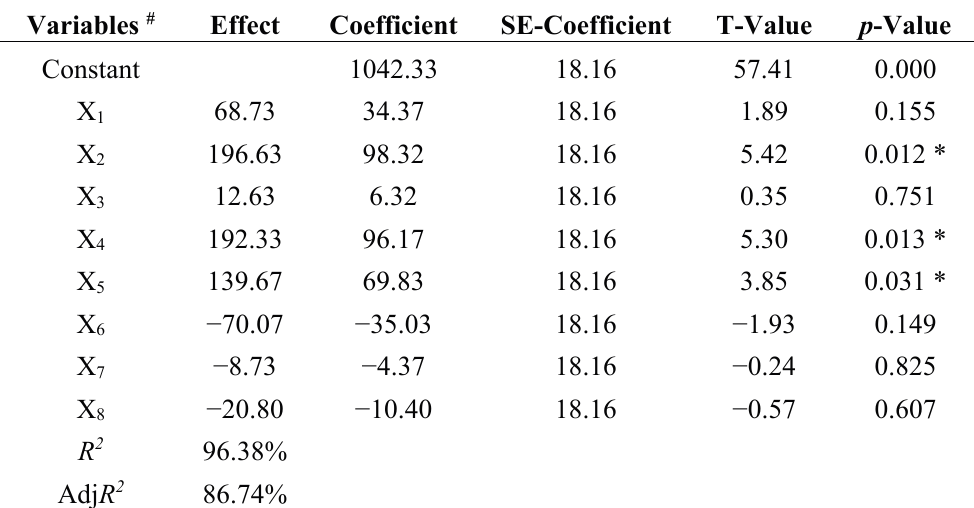
Table 2. Statistical analysis of Plackett-Burman